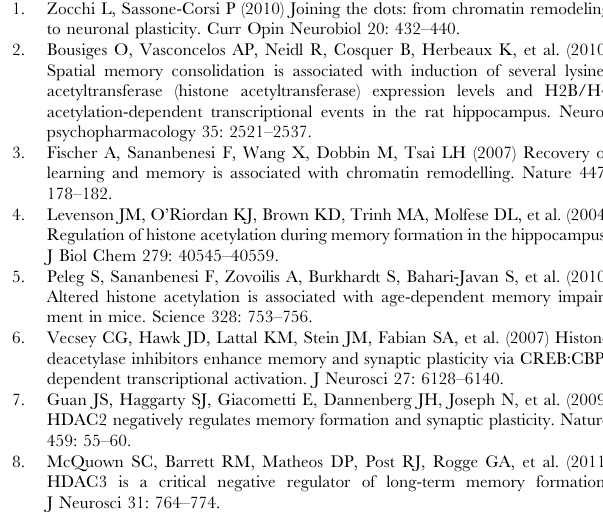
Figure S4 Peptide array technology (Active Motif) reveals the scope of histone PTM antibody selectivity. (A–D) Specificity value, calculated as the ratio of positively identified site modifications to negative site modifications, of various commercially available antibodies: (A) H3acetyl-K9, (B) H3acetyl-K14 (here termed H3-pan-acetyl (H3a) for western blotting methodology, where the band at the appropriate molecular weight for H3 was quantified, and termed Histone- pan-acetyl (Ha) for immunocytochemistry in Figure S1), (C) H3pS10, and (D) H4acetly-K12 (here termed H4-pan-acetyl, H4a). (E) Peptide array technology provides an evaluation of both antibody specificity and steric hindrance. The H3pS10 antibody, for example, was selective for the intended target (blue circled blots) and did not recognize most modifications in the absence of phospho-serine-10 (e.g., H3-acetylK9; red, and H3-phosphoT11; yellow). In the presence of phosphoT11, however, the antibody failed to bind phospho-S10 (green